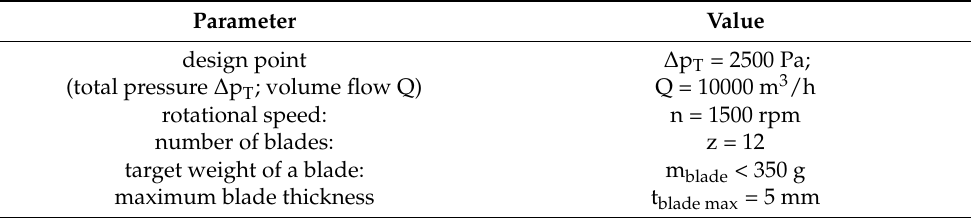
Table 2. Boundary conditions FE simulation.